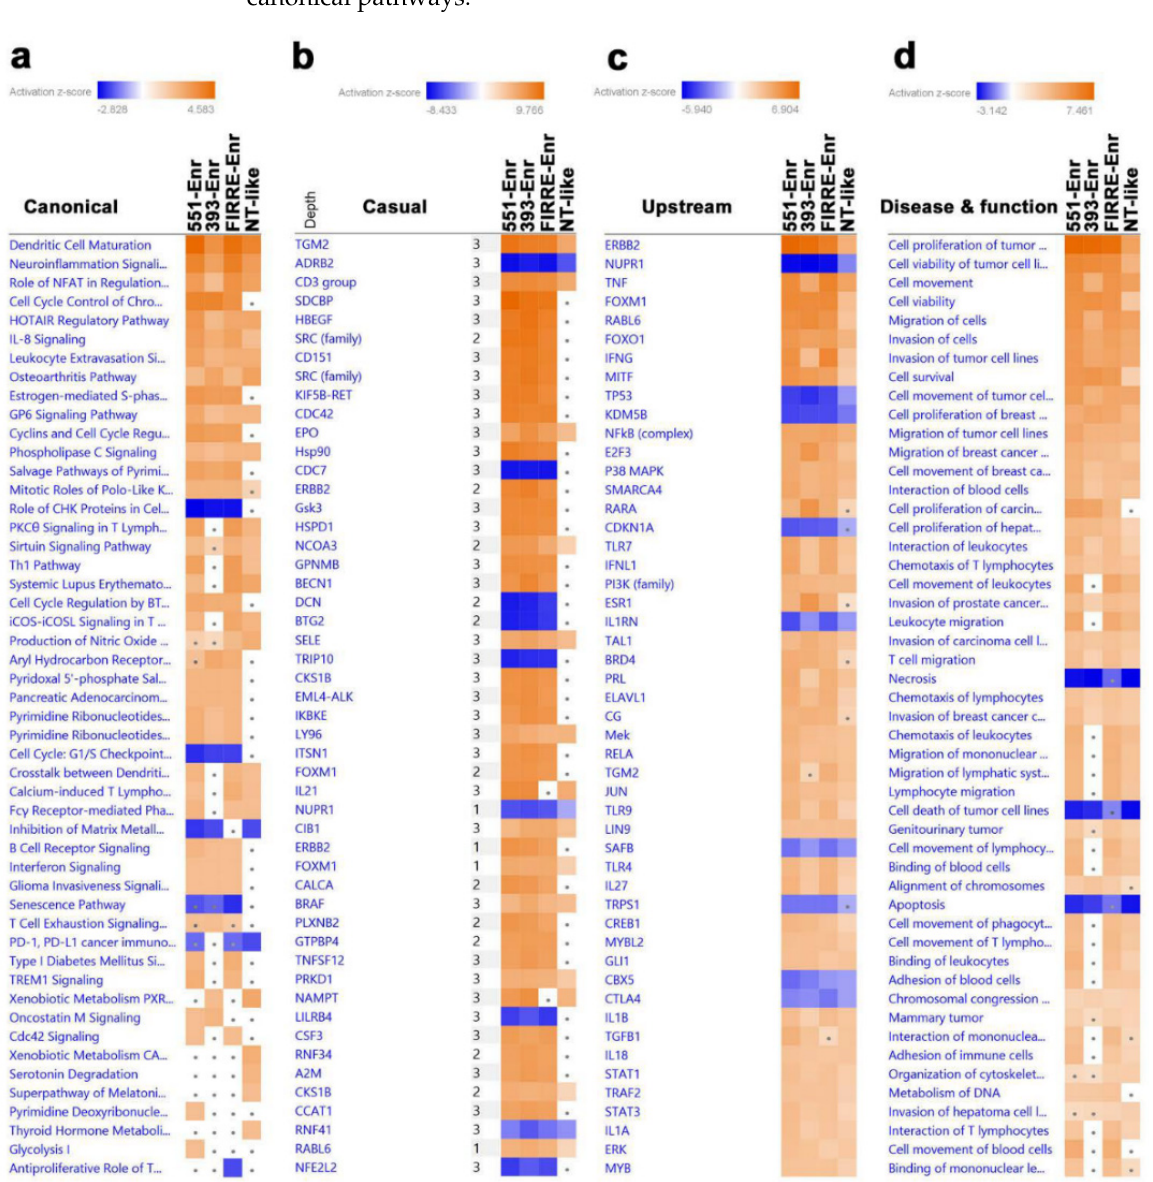
Figure 4. Upstream regulator and functional annotation enrichment in lncRNA-derived TNBC clusters. Upregulated genes from each lncRNA-derived TNBC cluster compared to NT were subjected to comparative casual ( a ), canonical ( b ), upstream ( c ), and disease and function ( d ) analysis using IPA illustrating the top affected categories. Color intensity corresponds to the activation Z-score. 551-Enr, LINC00511-enriched; 393-Enr, LINC00393-enriched; FIRRE-Enr, FIRRE-enriched; NT-like, normal tissue-like; NT, normal tissue.